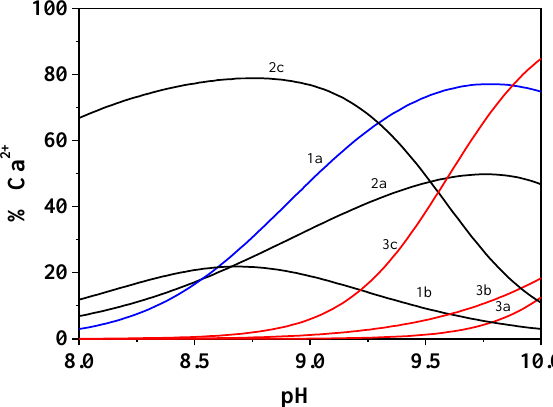
Figure 5. Distribution diagram for the Ca 2+ /Dop − species at I ~0.15 mol dm −3 and different tempera- tures. Species: 1 ML; 2 MLH; 3 MLOH.a: T = 288.15 K; b: T = 298.15 K; c: T = 310.15 K. (Experimental conditions: c Ca2+ = 1.5 mmol dm −3 ; c DOP− = 5 mmol dm −3 ) [M = Ca 2+ ; L = Dop − ].